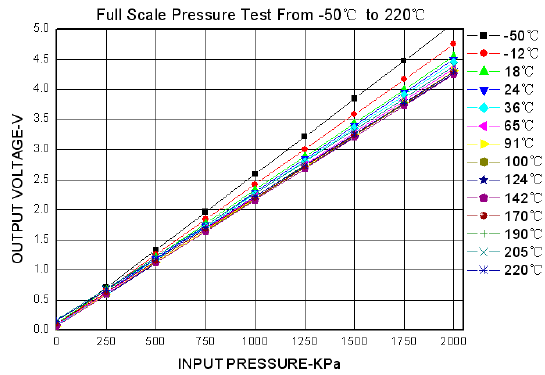
Figure 14. Pressure sensor calibration test results. Table 3. Performance comparison of similar sensor parameters.